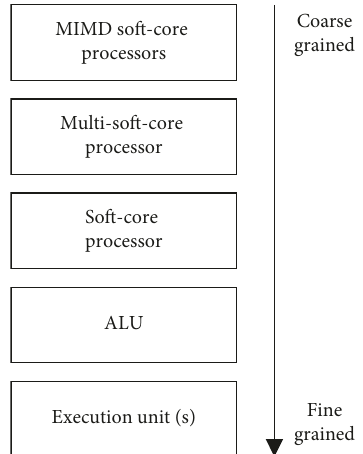
Figure 5: Soft-core-based reconfiguration granularities.